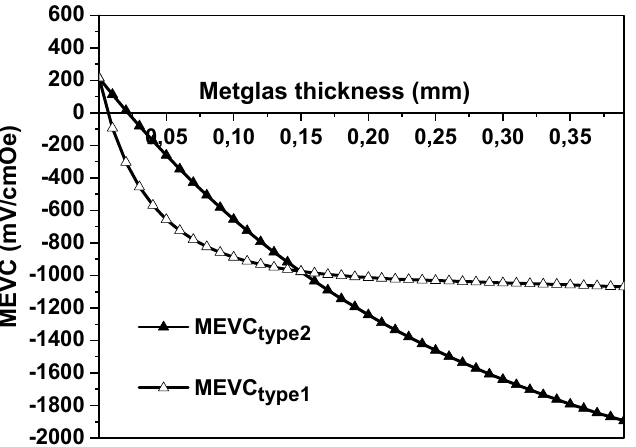
Figure 6. Estimated dependence of MEVC in Ni-PZT-Metglas (Type 1) and Ni-Metglas-PZT (Type 2) three-layered structures on the Metglas layer thickness. The PZT layer thickness t p = 0.2 mm, the Ni thickness t m 1 = 0.2 mm.